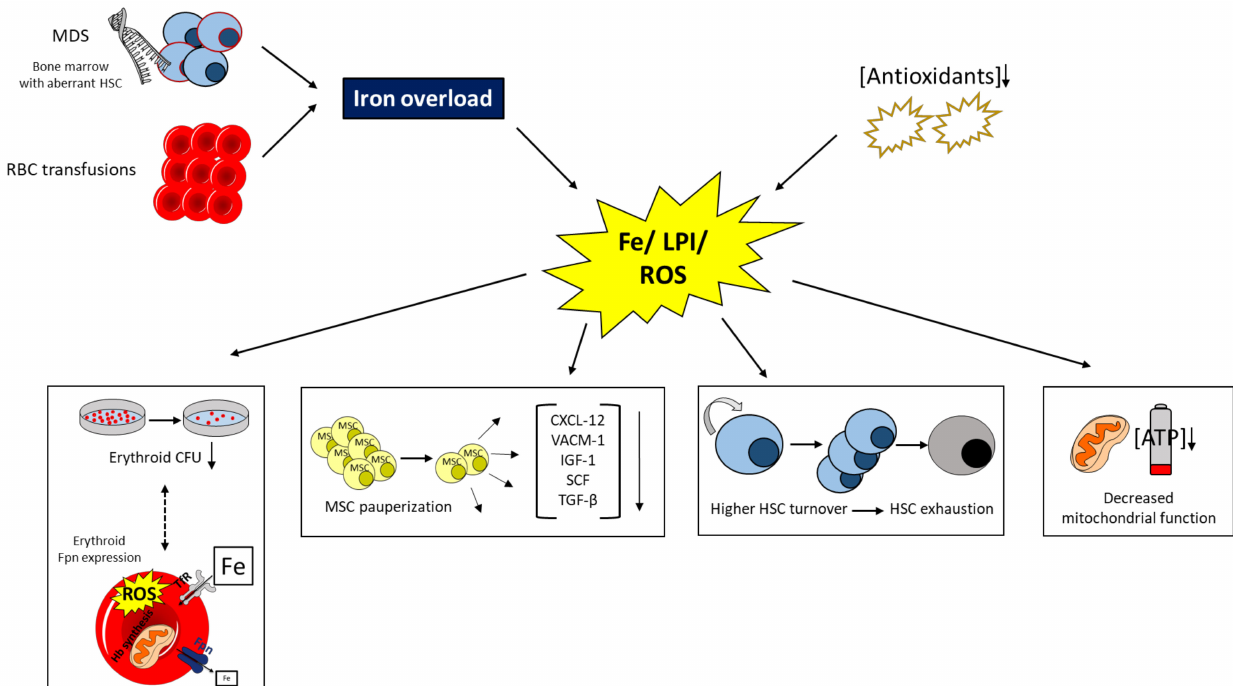
Figure 1. Mechanisms contributing to iron overload in patients with MDS and potential consequences. Dashed lines indicate a yet unclear interrelation. Myelodysplastic syndrome (MDS); hematopoietic stem cell (HSC); red blood cell (RBC); iron (Fe); labile plasma iron (LPI); reactive oxygen species (ROS); colony-forming unit (CFU); mesenchymal stem cell (MSC); C-X-C motif chemokine 12 (CXCL-12); vascular cell adhesion molecule 1 (VCAM-1); insulin-like growth factor 1 (IGF-1); stem cell factor (SCF); ferroportin (Fpn); adenosine triphosphate (ATP); transferrin receptor (TfR); hemoglobin